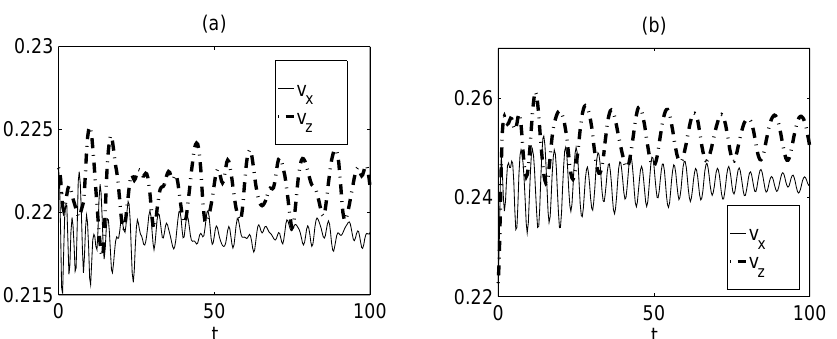
FIG. 22. rms velocities (in arbitrary units) for initially matched nonstationary distributions ( (cid:99) (cid:121) (cid:97) (cid:173) (cid:51)(cid:44) m (cid:120) (cid:173) m (cid:121) (cid:173) m (cid:122) (cid:173) (cid:49)(cid:46)(cid:48)(cid:44) h (cid:120) (cid:173) (cid:48)(cid:46)(cid:53)(cid:51)(cid:44) h (cid:122) (cid:173) (cid:48)(cid:46)(cid:51)(cid:57) ): (a) 6D uniform distribution and (b) 6D Gaussian